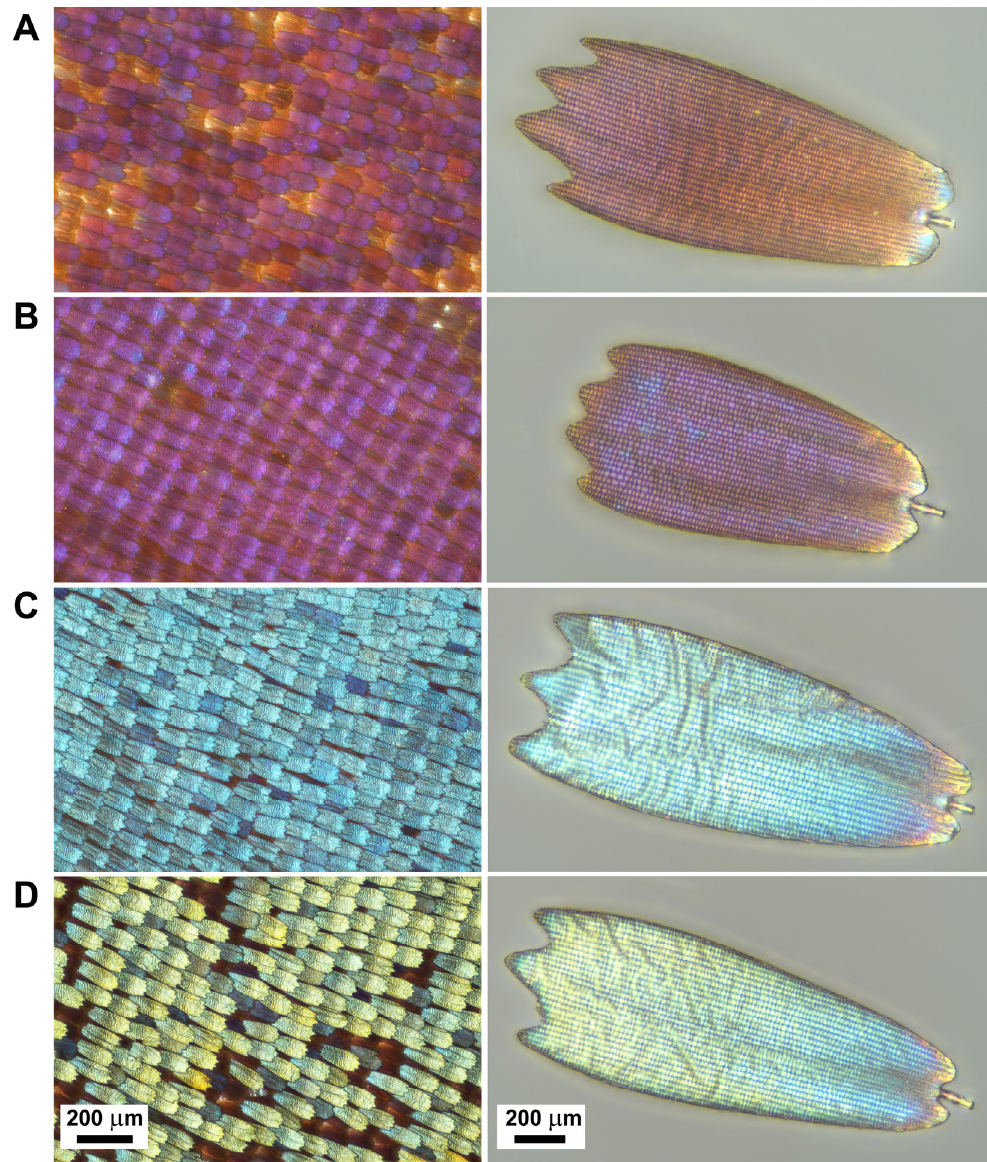
Figure 3. Optical micrographs of dorsal wing surface and an individual cover scale of various Euphaedra neophron morphs. ( A ) E. n. ellenbecki, ( B ) E. n. violaceae, ( C ) E. n. neophron, ( D ) E. n. zambesia .